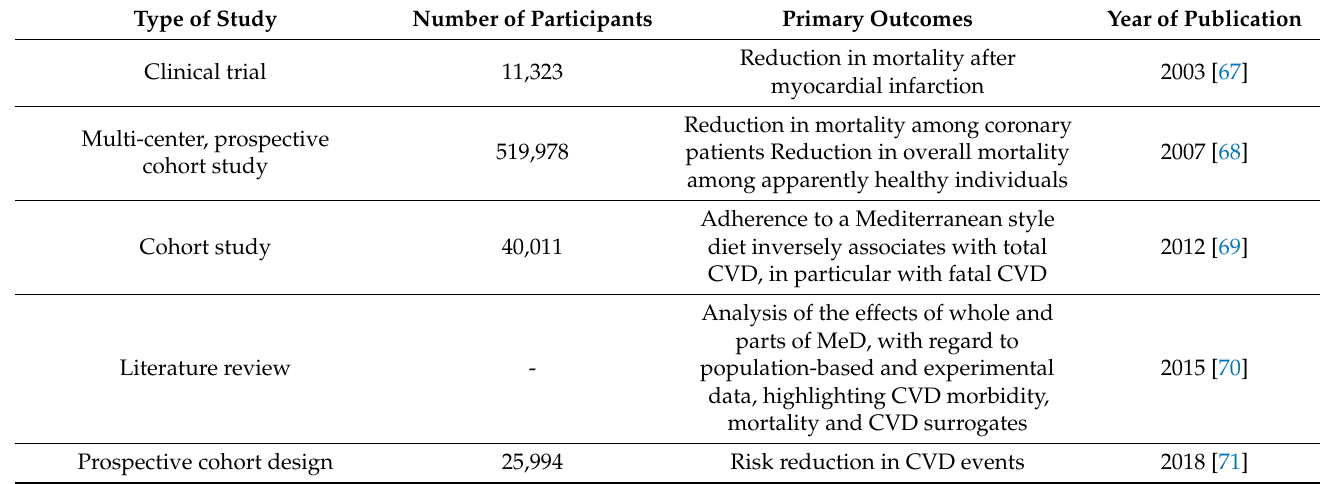
Table 2. Characteristics of studies describing the effects of a Mediterranean diet on cardiovascular diseases (CVDs). Type of